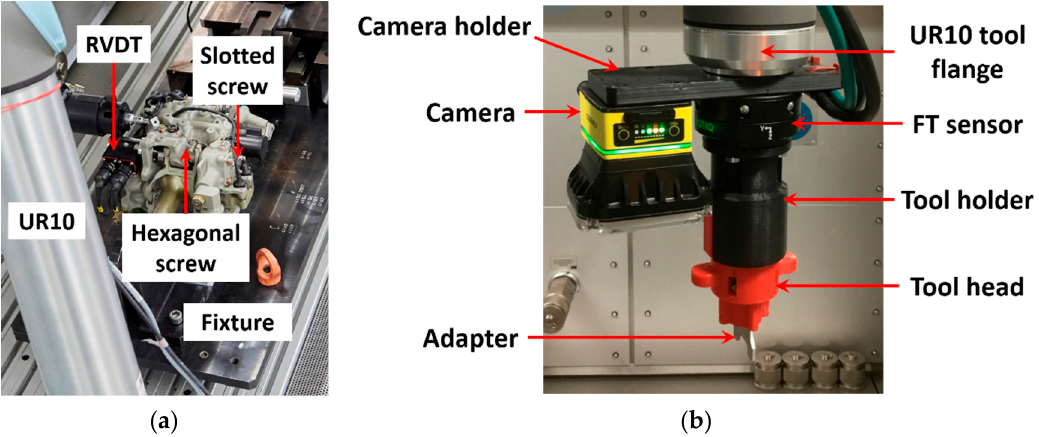
Figure 3. ( a ) Focus on the main components of a servo-actuator to be adjusted by the UR10 collaborative robot; ( b ) Tool mounted on UR10 tool flange consisting of a 2D camera, a force-torque sensor, and a customized wrench built via additive